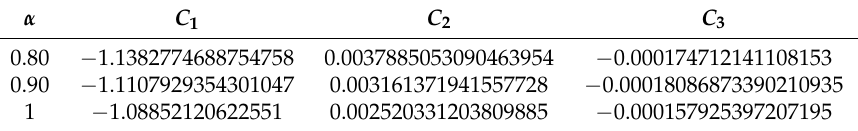
Table 2. Auxiliary Convergence-constants for dissimilar values of α of Example 1.